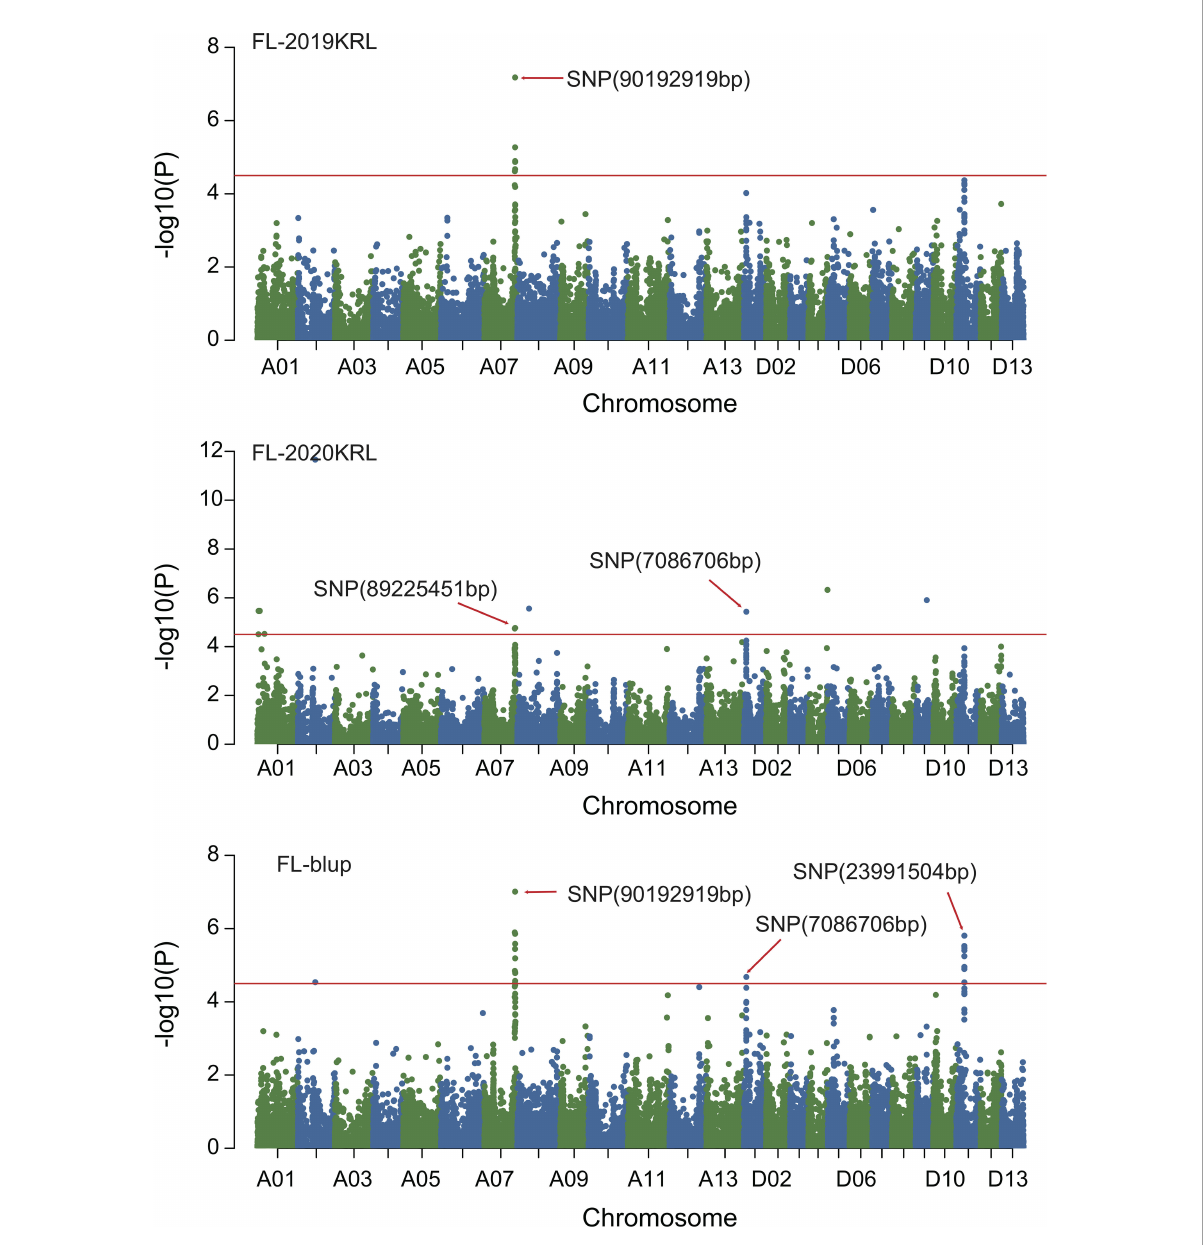
FIGURE 3 Manhattan of genome-wide association studies for fi ber length in Korla. FL-2019KRL: Fiber length in the Korla environment in 2019; FL- 2020KRL: Fiber length in the Korla environment in 2020; FL-blup: Fiber length in the blup